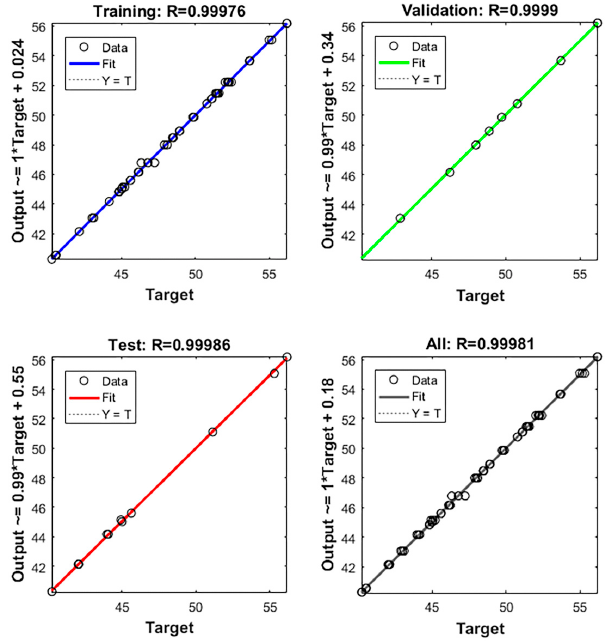
Figure 5. Fitted curves of the SEP from BP-ANN model training.